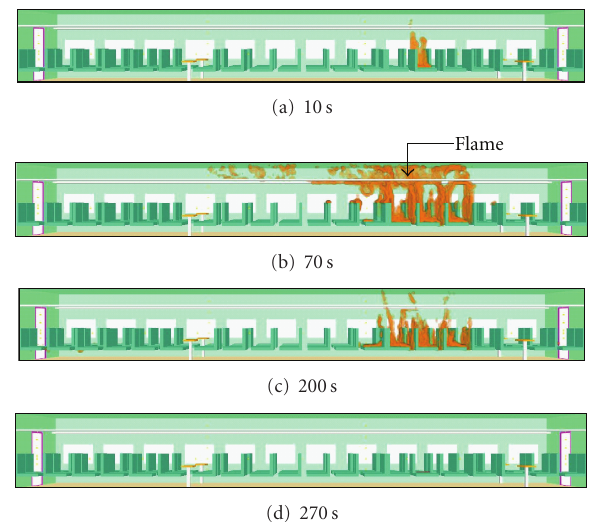
Figure 8: Smoke spread inside the train